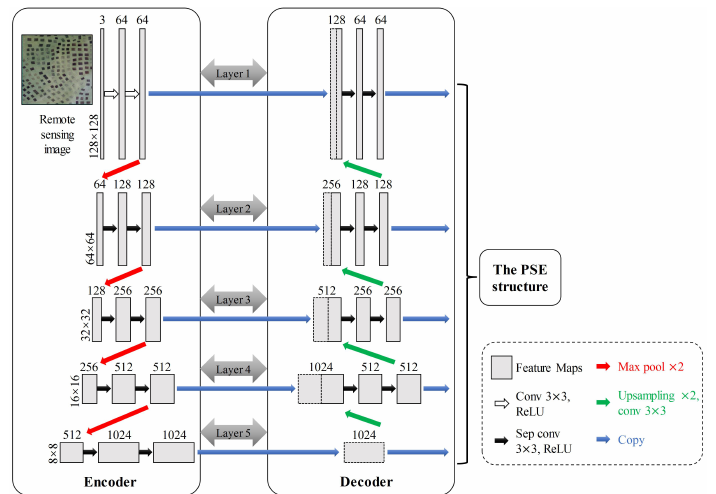
Figure 5. The improved U-Net. Each gray rectangle represents a multichannel feature map with the channel number at the top of the gray rectangle and the size on the left